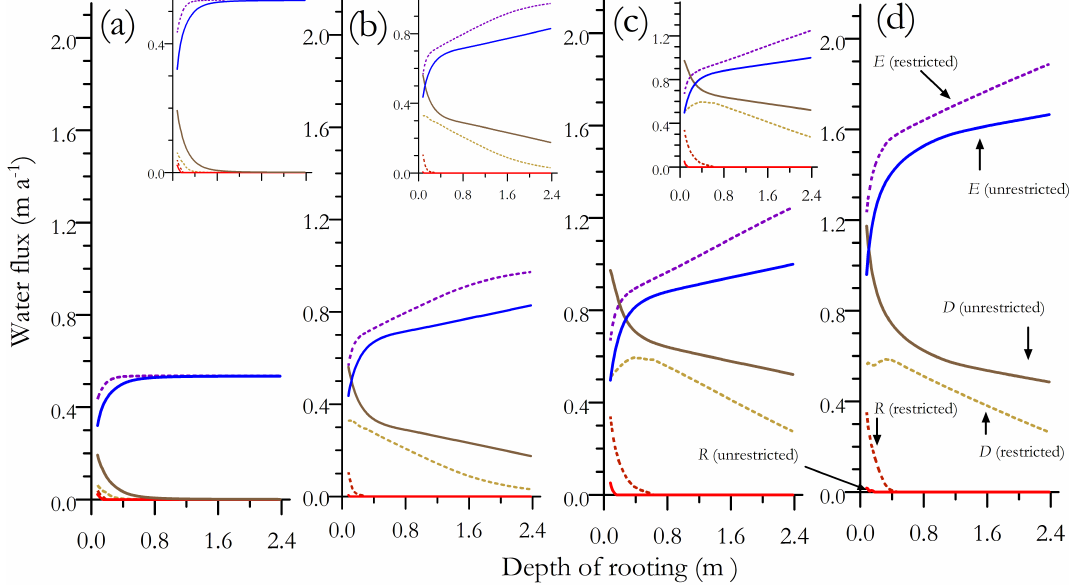
Figure B2. Simulated effects of the presence or absence or impermeable layer on soil water budgets across a range of rooting soil depths as affected by the precipitation regimes ( P A ) of Fig. B1b. (a) P A = TUC-01, (b) P A = 0 . 7KEN-01, (c) P A = KEN-01 and (d) P A = TAP-04. In all cases the main y axis has been scaled with a maximum value equal to the mean annual precipitation at TAP-04 ( P A = 2 . 15ma − 1 ). Insets in (a–c) show same data, but with the y axis according to P A at the site in question. Shown are model predictions for evapotranspiration ( E ), drainage ( D ) and runoff ( R ) as (1) a function of rooting depth where for the restricted case maximum rooting depth ( Z max ) is assumed to be restricted by an impermeable layer at the same depth (“restricted” case) and (2) where there is no imposed restriction on Z max (“unrestricted”